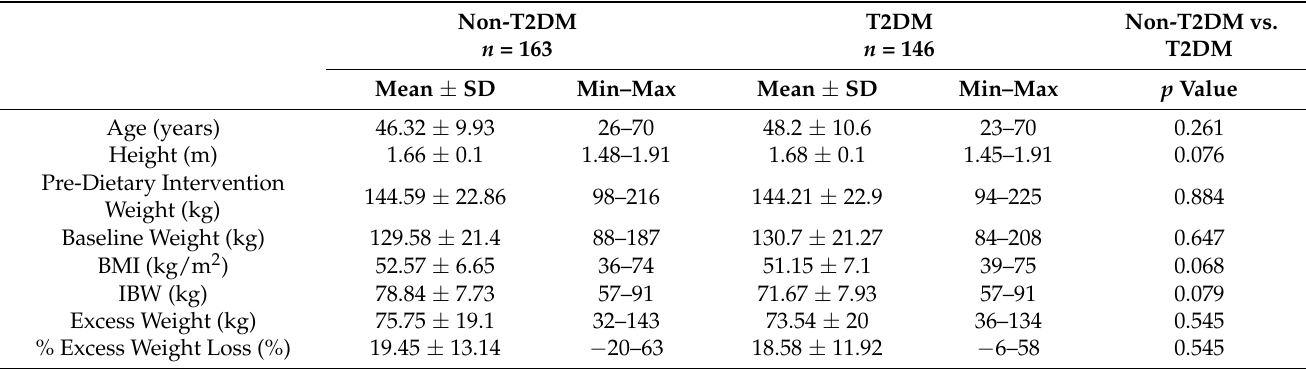
Table 1. Starting demographics of non-T2DM and T2DM